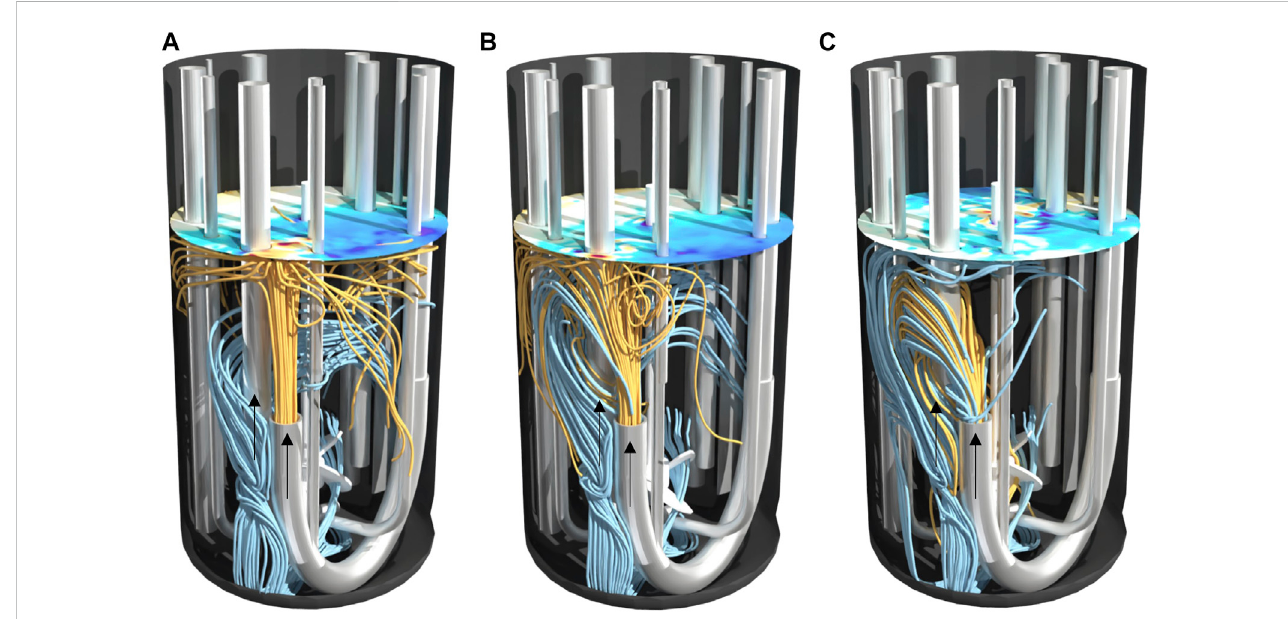
FIGURE 5 Streamlinesin2 LbioreactorofsetupIIatdifferentpowerinputs (A) 10 W/m³, (B) 27 W/m³and (C) 58 W/m³.Streamlinescalculatedforwardsinorangeas in fl ow and streamlines calculated backwards in blue as out fl ow. The surface color indicates the topology of the vortex.